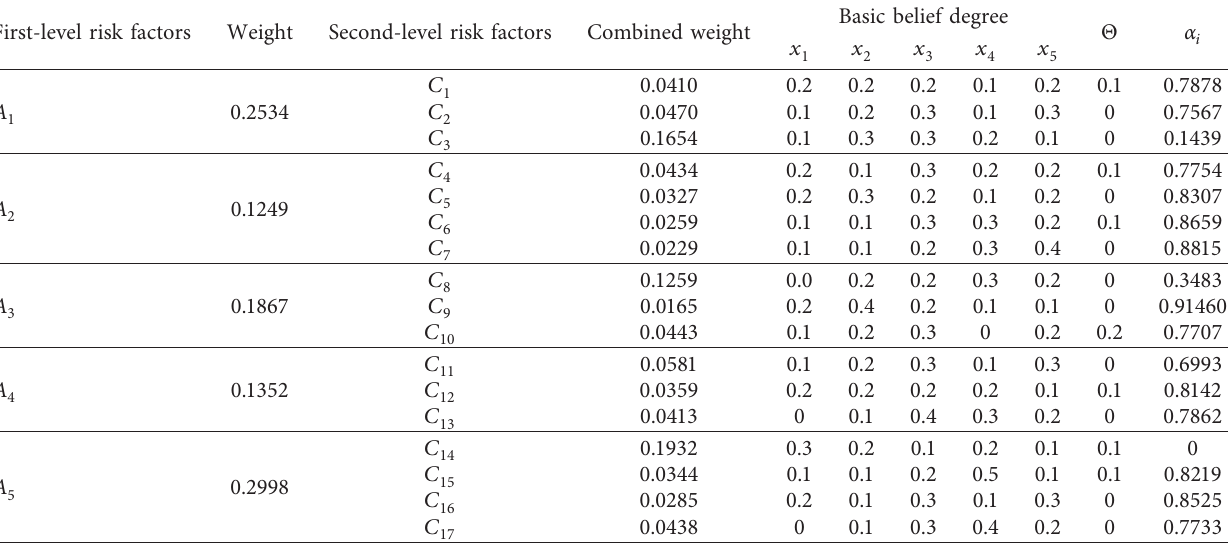
Table 7: The basic belief degree, Θ , and discount rate.